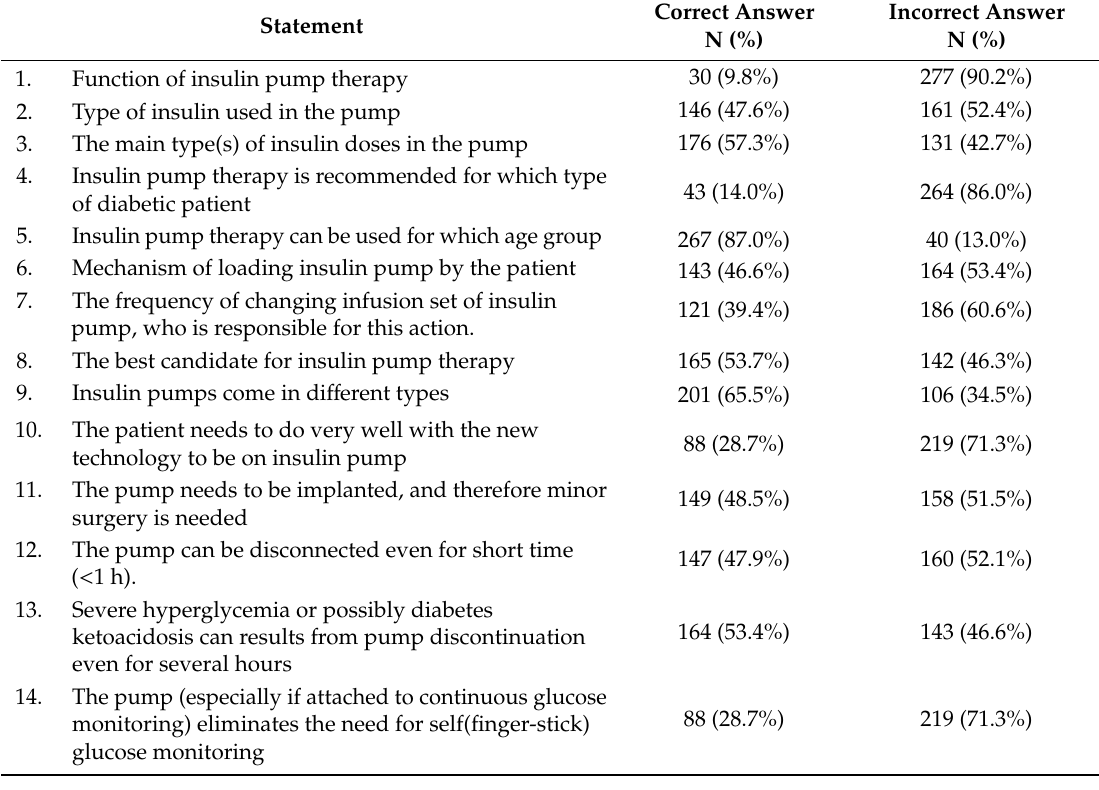
Table 2. Assessment of the knowledge regarding insulin pump therapy (n = 307).